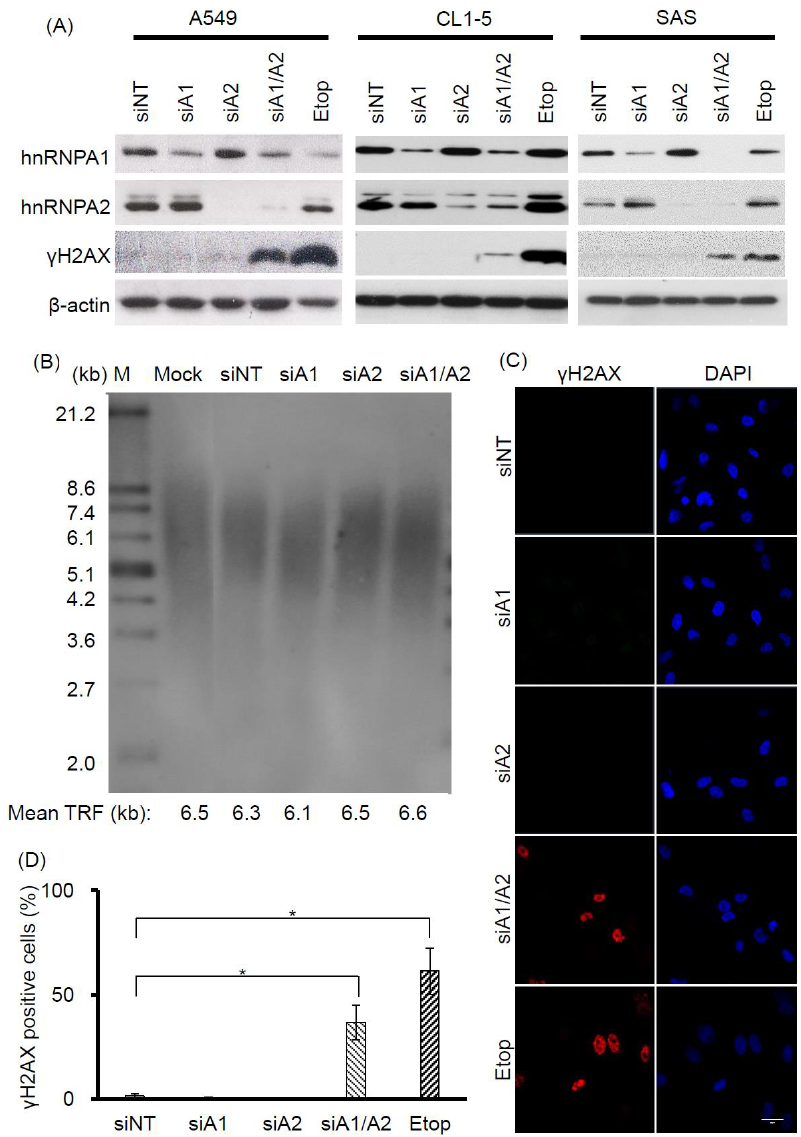
Figure 1. Effects of depleting hnRNP A1 and/or hnRNP A2 on induction of DNA damage response (DDR). ( A ) Induction of γH2AX . A549, CL1-5, and SAS cells were transfected with siRNA targeting